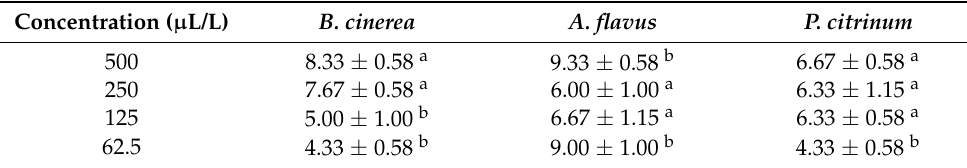
Table 6. Antifungal activity of FEO. Inhibition zones measured in mm.